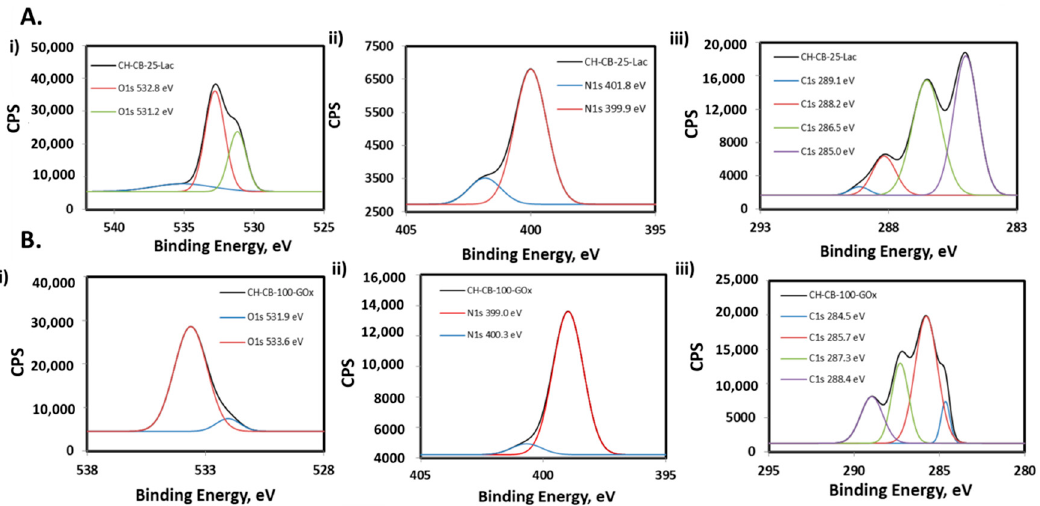
Figure 4. XPS spectra of ( A ) Laccasse CH-CB-25 membrane and ( B ) GOx CH-CB-100 membrane showing high resolution regions of ( i ) O1s, ( ii ) N1s, and ( iii ) C1s.